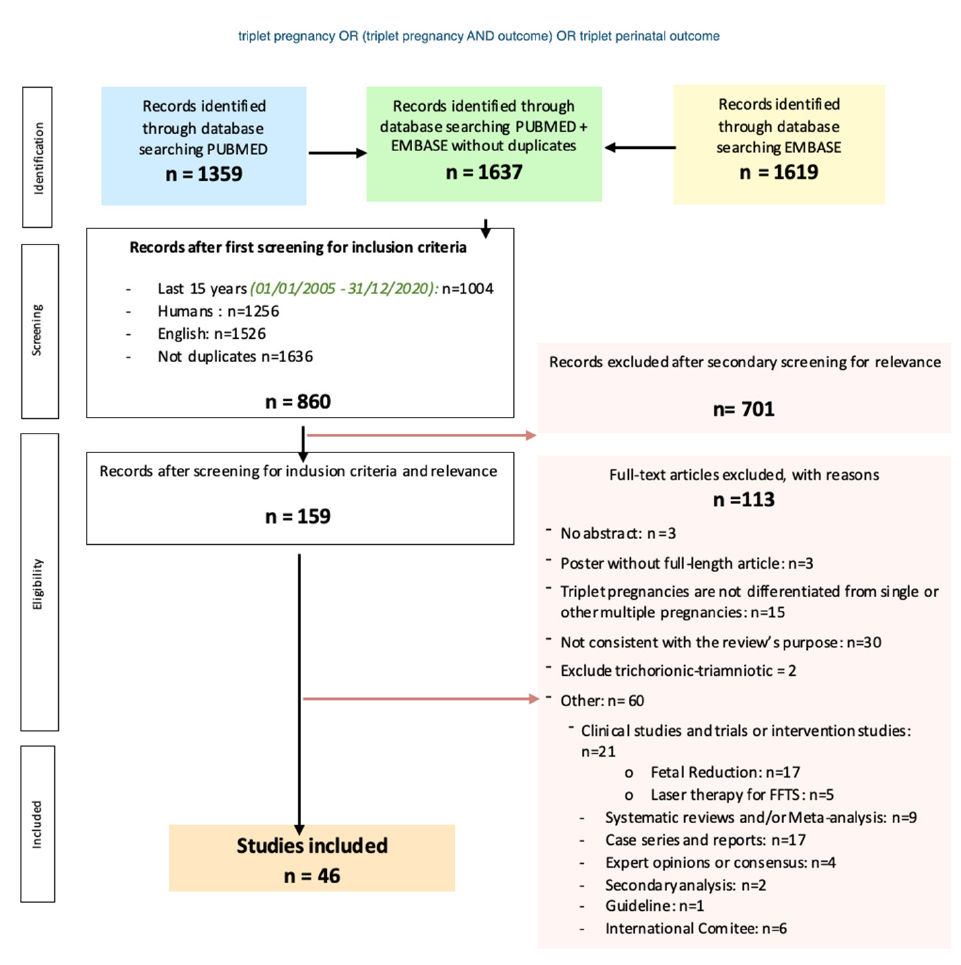
Figure 1. Flowchart of the systematic review, search strategy, inclusion and exclusion criteria. Table 1. Characteristics of the studies included in the systematic review and